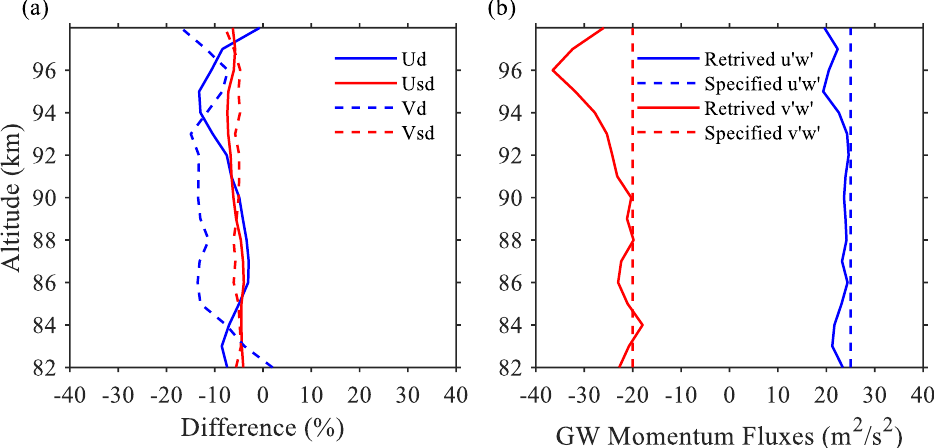
Figure 4. ( a ) Differences of the amplitudes of the diurnal (red lines) and semidiurnal (blue lines) tides, between the estimated ones and the specified ones for case 1, using the angular information detected in July 2012. The solid and dashed lines are for the zonal and meridional direction, respectively ( b ).